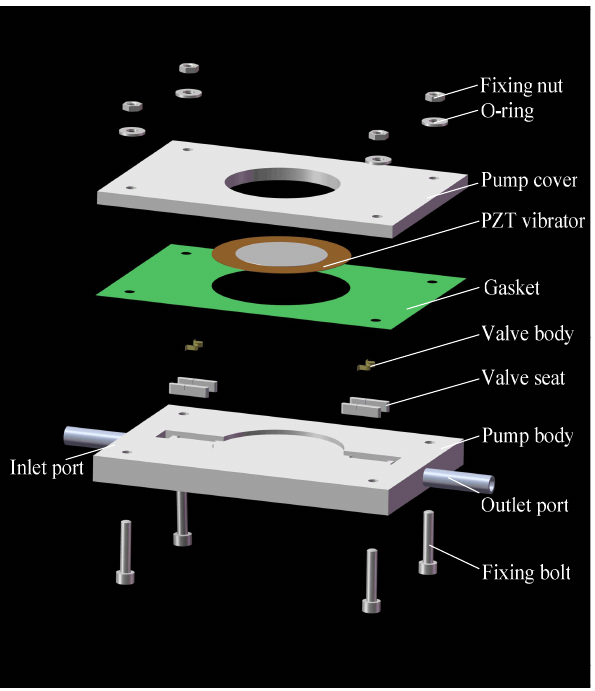
Figure 3. Illustrative diagram of the PPCVLS with different parts. Figure 4a is the working-principle diagram of the valve-less state of the PPCVLS.